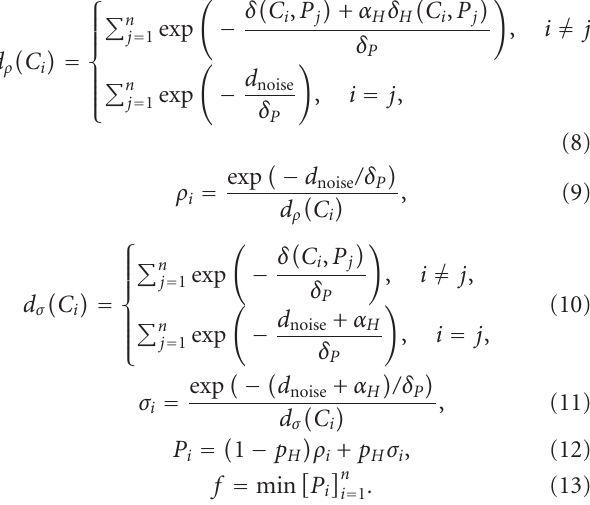
Figure 6, the average of best fitness value (for 100 runs) in each generation step was plotted. The standard deviation is drawn as vertical